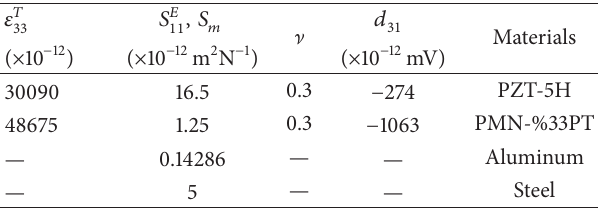
Table 1: Piezoelectric and substrate materials properties.